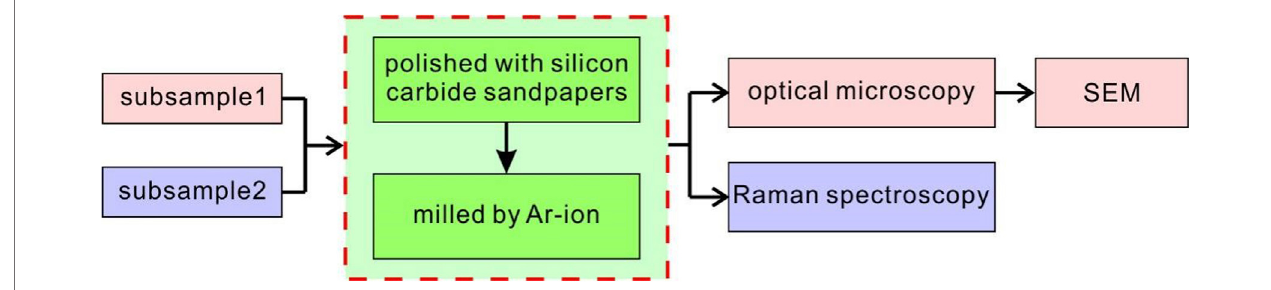
FIGURE2| Flowchartofexperimentalanalysis,whichmainlyincludestheimmersionoilre fl ectedlightobservationandRamanspectrumtesting.Subsample1was tested by immersion oil re fl ected light and SEM, and subsample 2 was tested by Raman spectroscopy.